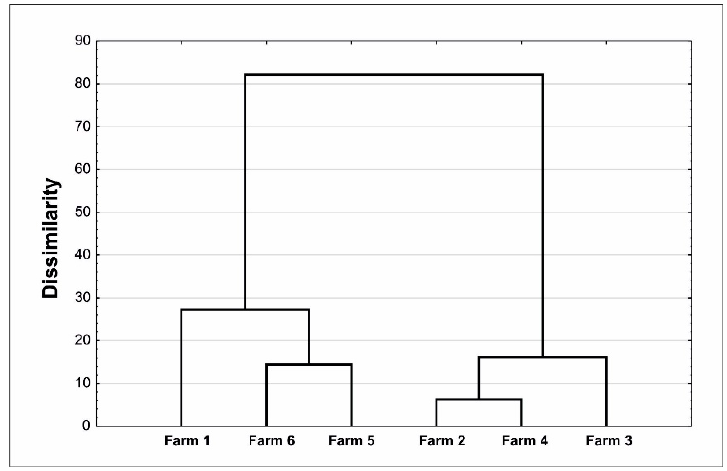
Figure 4. Grouping of waters inflowing to fish farms with the Ward hierarchical method.